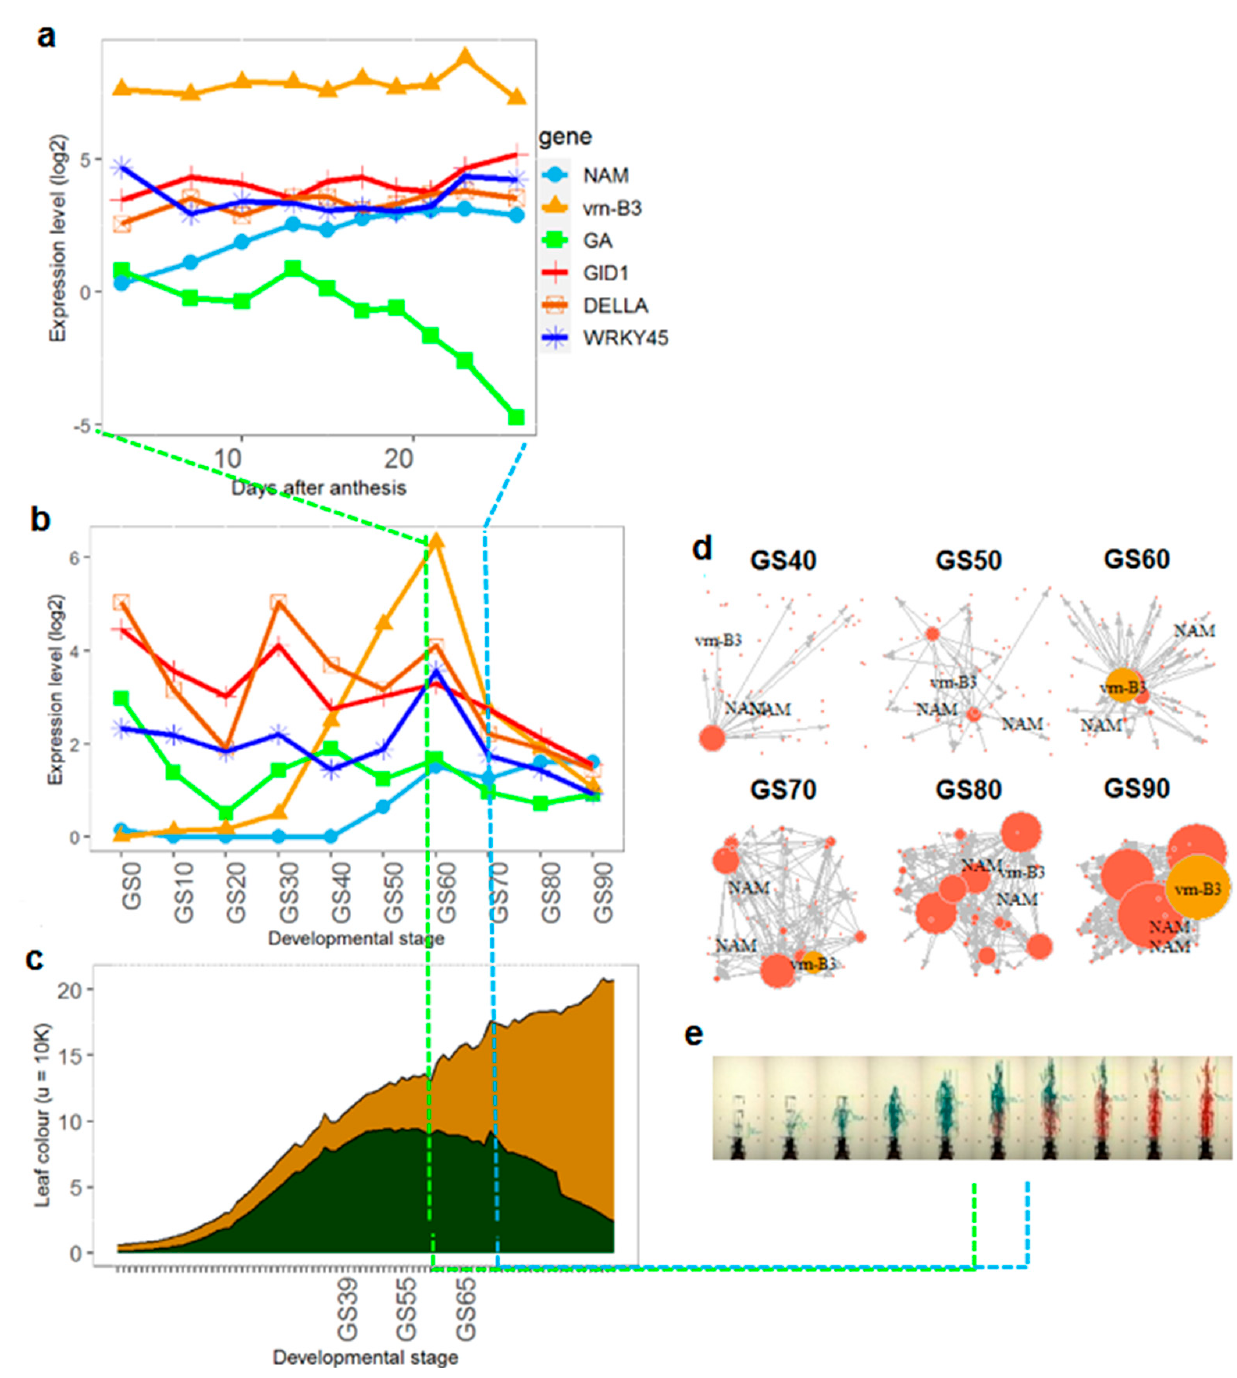
Figure 1. Moving beyond the limits of current senescence research: an integrative approach towards dissecting senescence. Gene expression profiles, from leaf tissues, corresponding to members of the NAM gene family (light blue) and VRN-B3 (amber) at ( a ) a narrow developmental window around anthesis (the traditional approach), contrasted with ( b ) our analysis across the wheat lifecycle, from seedling emergency to grain ripening (see Table 1 for growth stages), using public data. ( c ) Colour plot describing average colour changes of MAGIC lines over the lifecycle. Green and senesced areas in the plant are represented by green and yellow, respectively (see Table 1 for growth stages). ( d ) Lines and parents of the wheat MAGIC population imaged across their lifecycle. ( e ) Topological senescence gene networks from GS40 to GS90 inferred from ( b